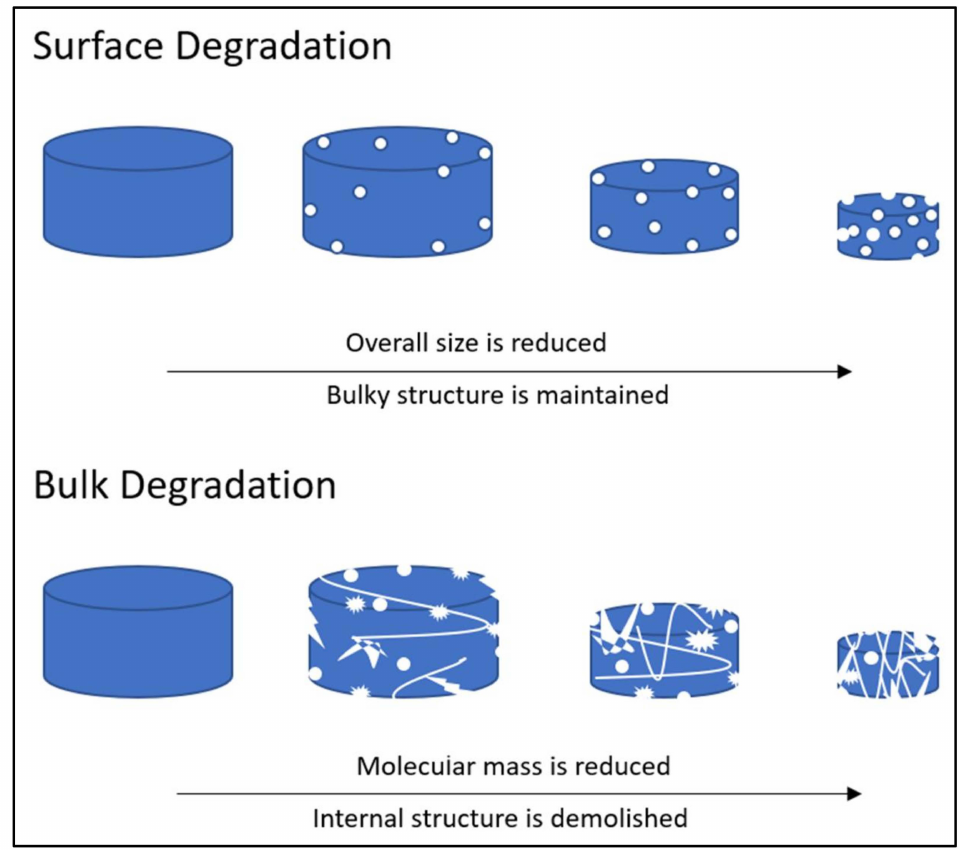
Figure 6. Illustrations of the surface and bulk degradation